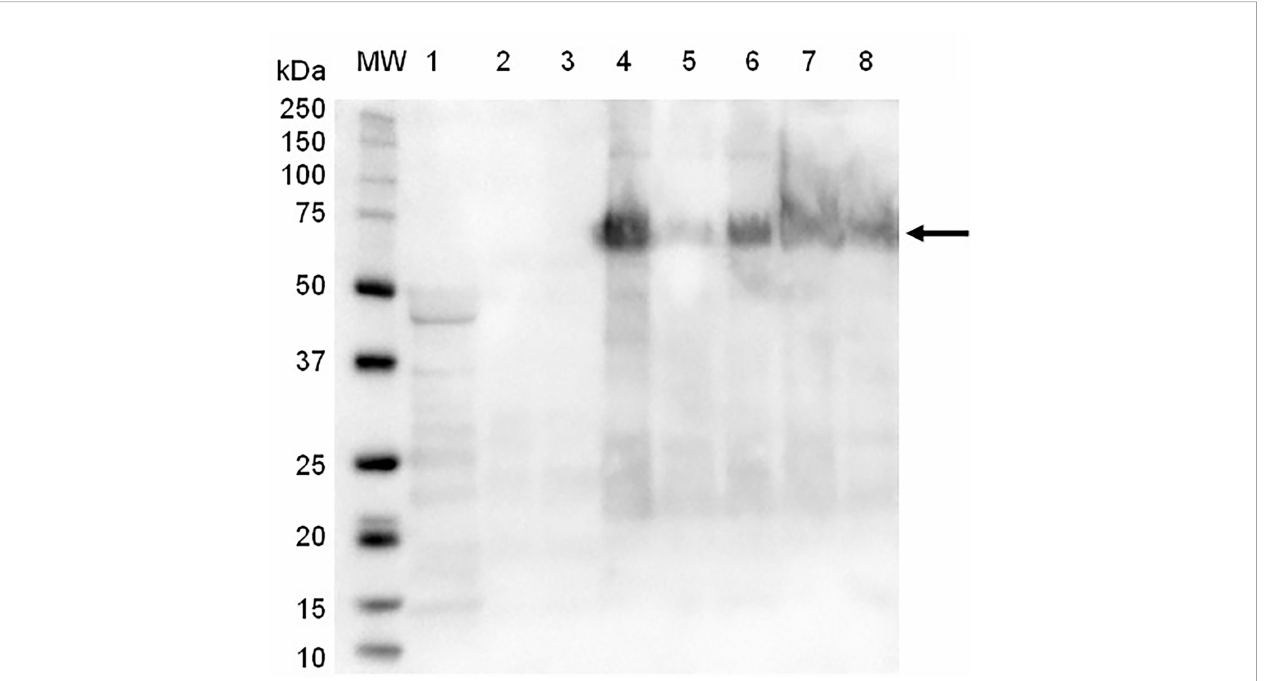
FIGURE 2 Immunoblot of partially-puri fi ed plant-produce ND VLPs obtained with the co-expression of NDV Fusion (F), hemagglutinin-neuraminidase (HN) and/or Matrix (M) proteins, using NDV antiserum and goat-anti-chicken IgY-HRP as secondary antibody. Lane 1: negative control – plant-expressed pEAQ-HT; lane 2: F only; lane 3: F + M; lane 4: HN only; lane 7: HN + M; lanes 5, 6 and 8: F + HN + M . Lane MW: The WesternC protein molecular weight marker was used. The arrow indicates the positions of the HN protein (approximately 62 kDa).